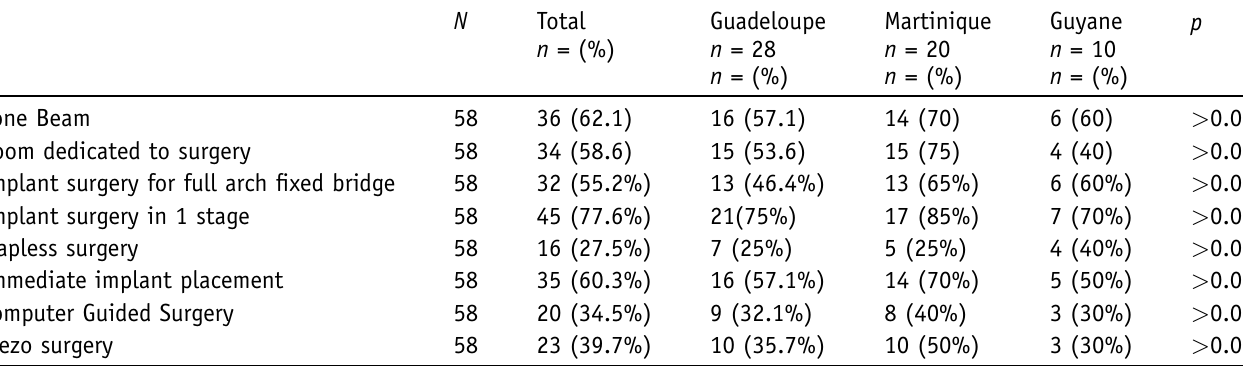
Table 3. Surgical procedures of dentists who provide dental implant surgery in Guadeloupe, Martinique and French Guyana.